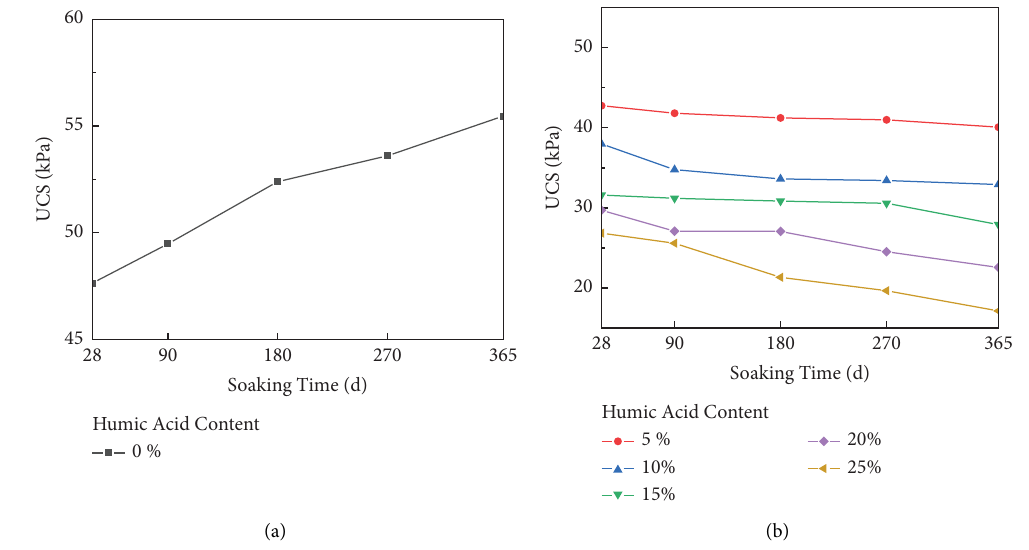
Figure 4: Relationship curve between sample UCS and soaking age.